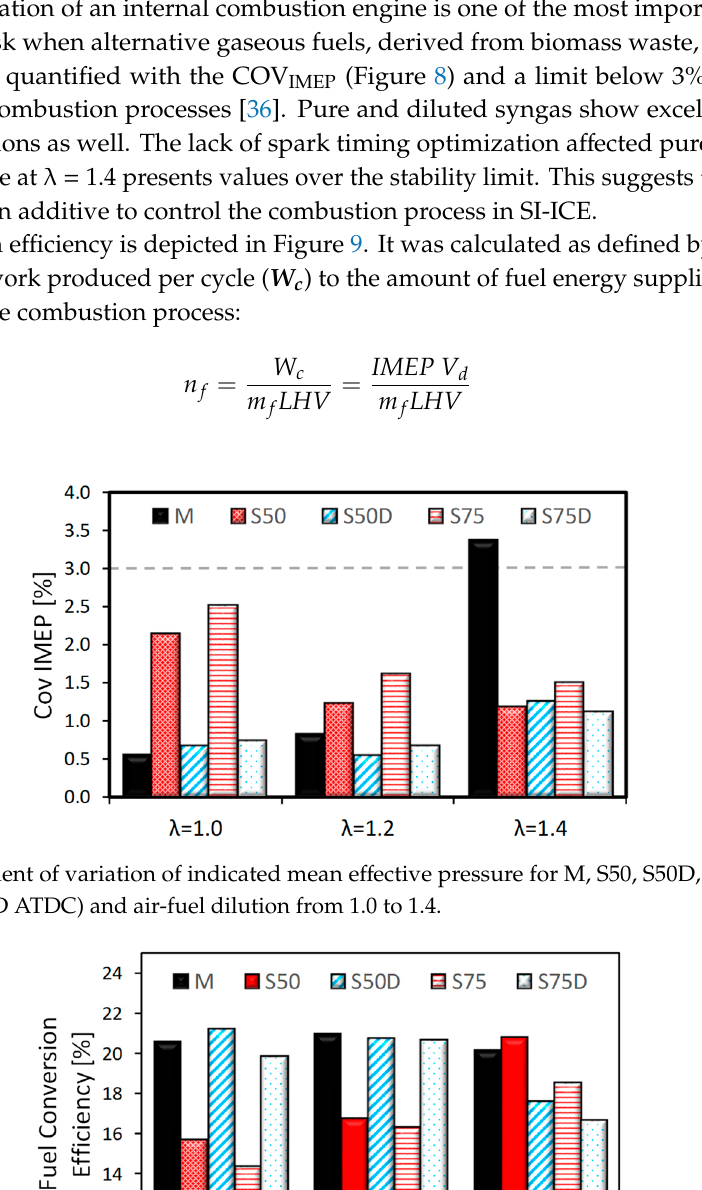
Figure 9. Fuel conversion efficiency average for M, S50, S50D and S75D at fixed SA ( − 7 CAD ATDC) and air-fuel dilution from 1.0 to 1.4.